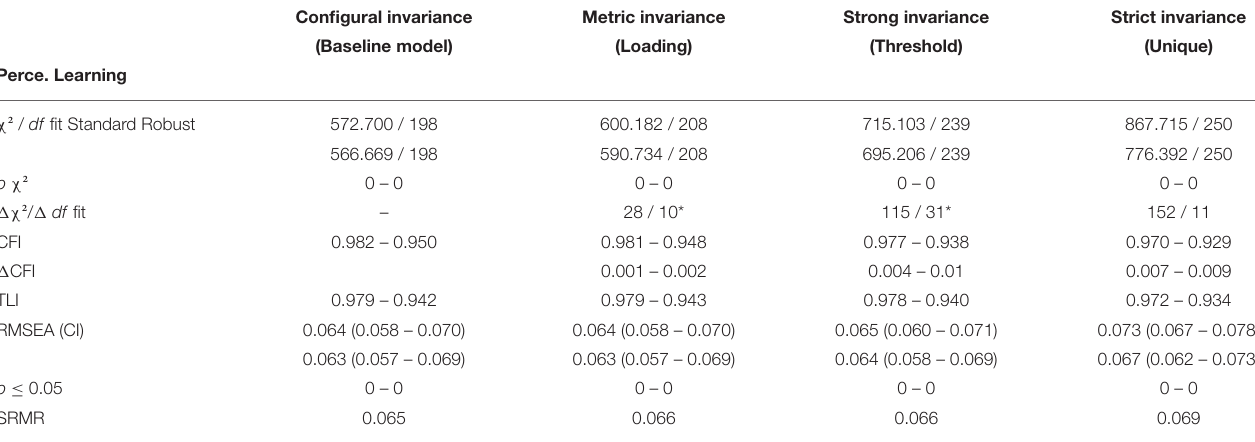
TABLE 5 | Analysis of longitudinal factorial invariance for the variable perceived